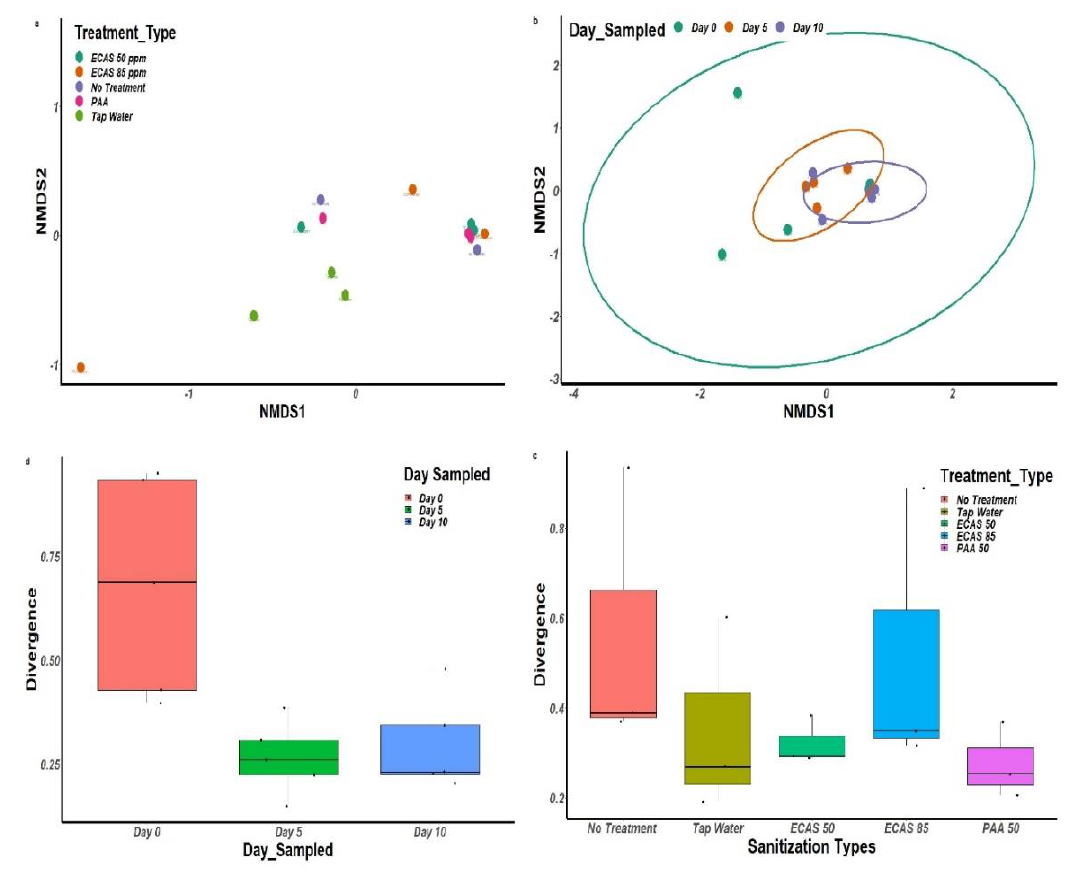
Figure 2. Microbial community cluster analysis of assembled sequence variants (ASV) non-metric multidimensional scaling (NMDS) based on Bray-Curtis dissimilarity index for ( a ) electrochemically activated solution (ECAS), tap water, and PAA washing, and ( b ) sampling days. Dispersion of the beta diversity group based on Bray–Curtis dissimilarity index for ( c ) ECAS, tap water, and PAA washing, and ( d ) sampling days. Table 3. ( a ) Permutational multivariate analysis of variance (PERMANOVA) results based on Bray- Curtis dissimilarities using abundance data for treatment types and sampling days. ( b ) Analysis of variance (ANOVA) pairwise comparison tests of dispersion of microbial composition among sampling days (significant if p value < 0.05).